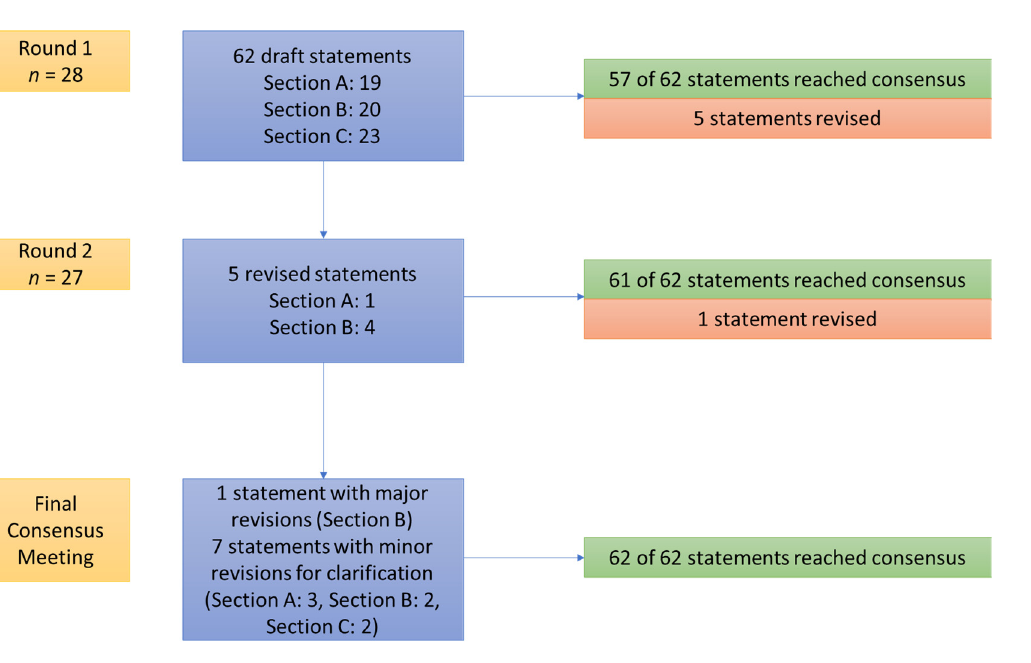
Figure 1. Overview of the consensus process.